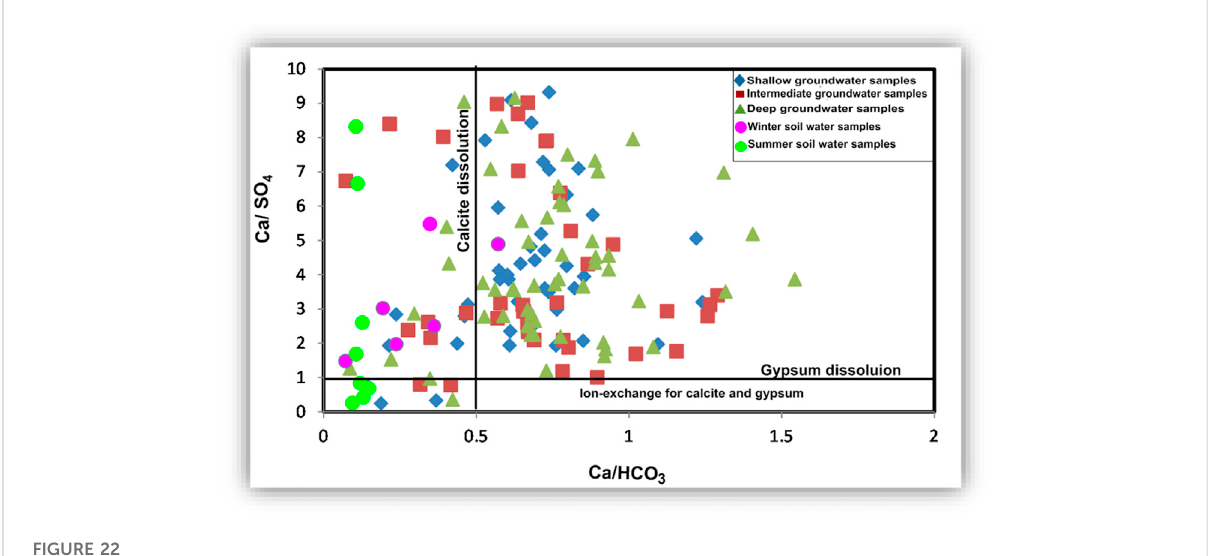
FIGURE 22 Binary relationship to estimate the effect of the ion exchange process on gypsum and calcite composition and the calcite and gypsum